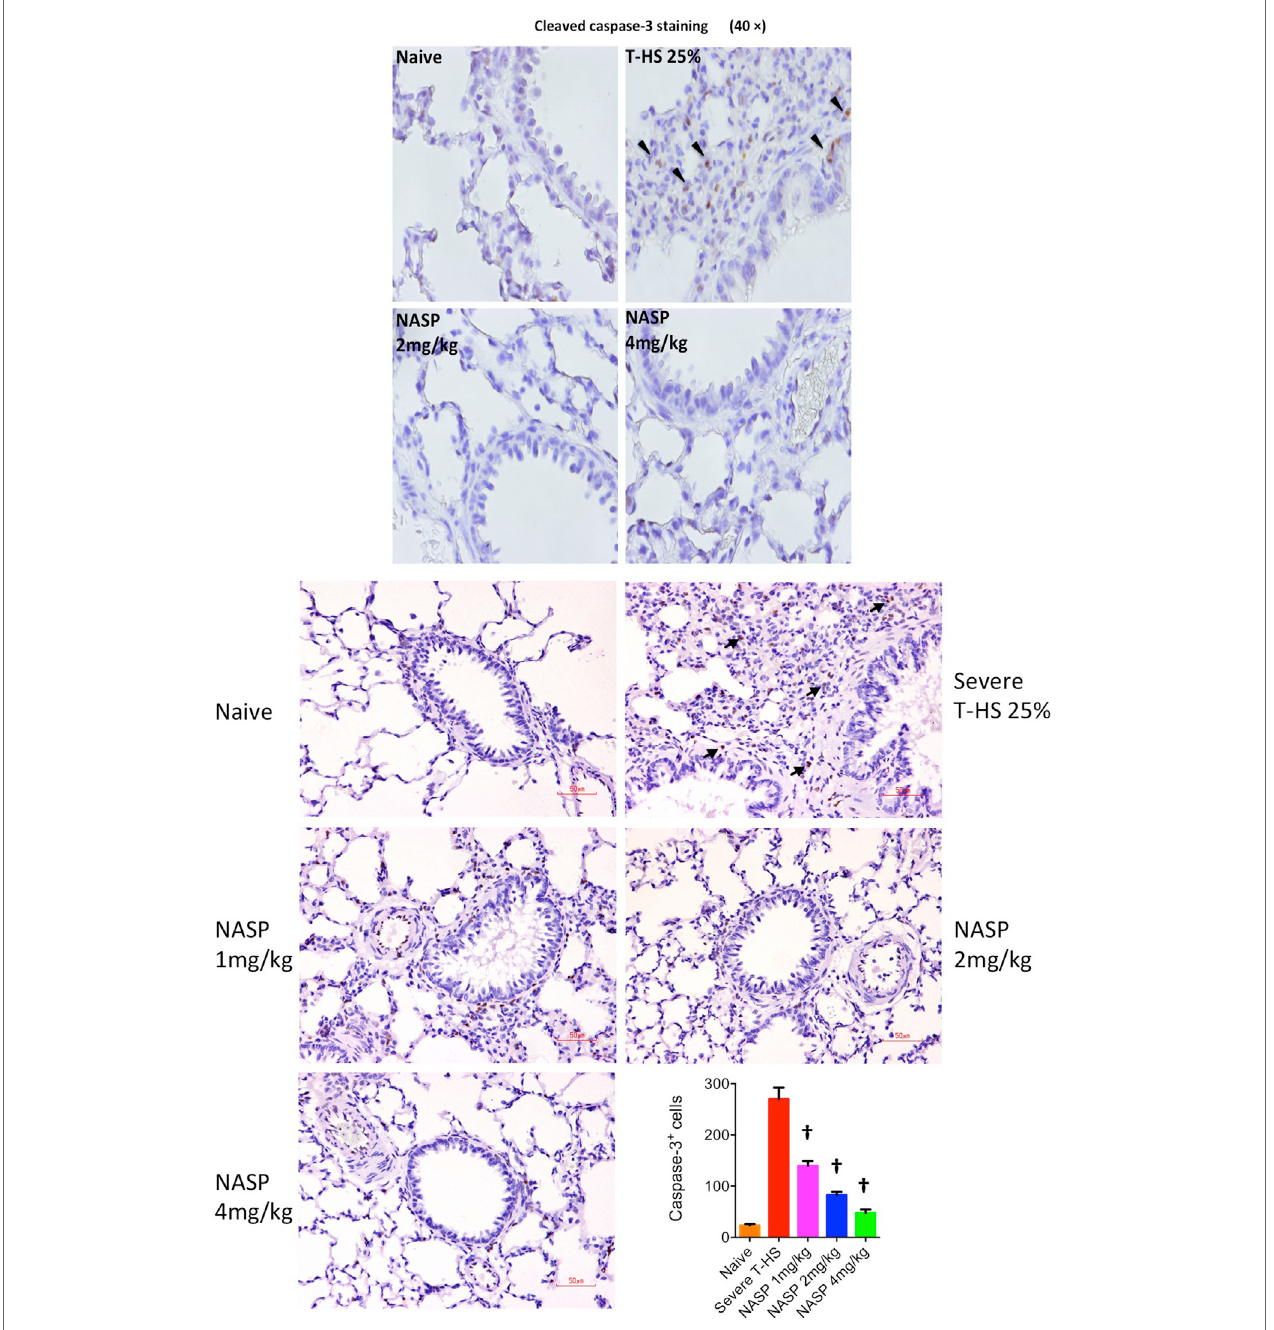
FigUre 8 | Nucleic acid scavenging polymer (NASP) (hexadimethrine bromide) treatment of rodent T-HS improved lung histological appearances. Cleaved caspase-3 staining was used to evaluate apoptotic cell death. NASP treatment showed a dose-dependent reduction of apoptotic cell death. † denotes p < 0.01 vs untreated severe T-HS 25%, t -test. n = 4–8 animals per group. Dark arrows indicate cleaved caspase-3 cells. Scale bar represents 50